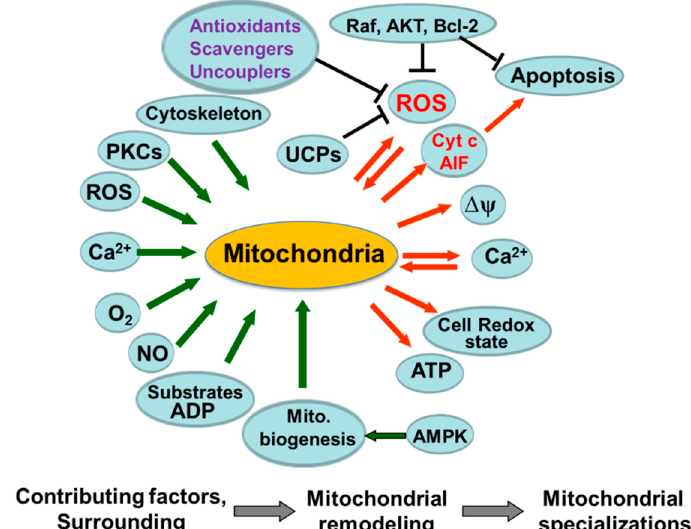
Figure3. Aschemesummarizinghypothesesregardingthepossibleoriginandmechanismscontributing to the heterogeneity of mitochondria and mitochondrial function. Complex communications of mitochondria with a cell at rest and factors which can be involved in the formation of mitochondrial heterogeneity are shown. ∆Ψ —mitochondrial potential. AMPK—AMP-activated protein kinase; PKC—protein kinase C; UCPs—uncoupling proteins; AIF—apoptosis- inducing factor; Raf—rapidly accelerated fibrosarcoma (RAF protein kinases); AKT—Protein kinase B (Akt, serine / threonine protein kinase); Bcl-2—(B-cell lymphoma 2 protein) antagonist of cell death.